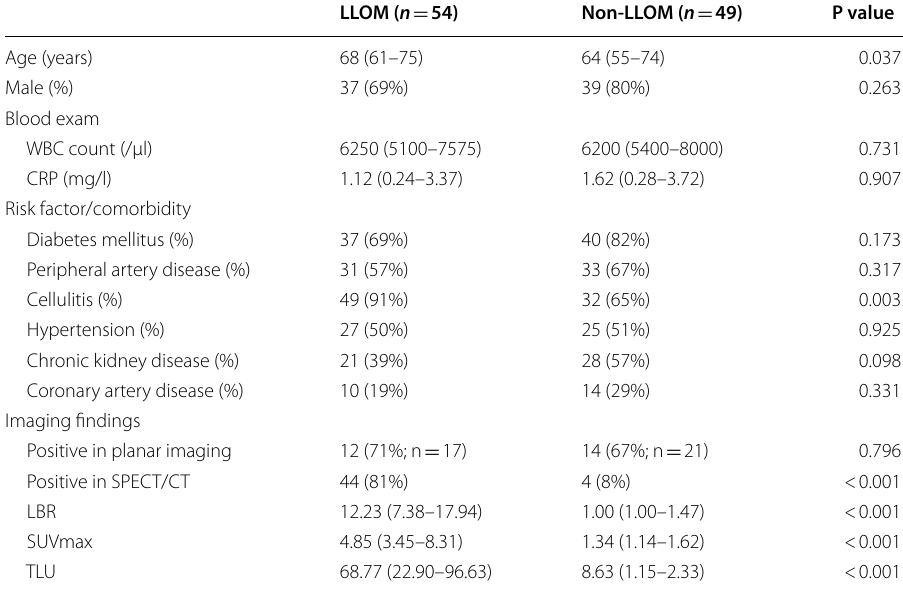
Table 3 Comparison of clinical profiles between LLOM and non-LLOM groups